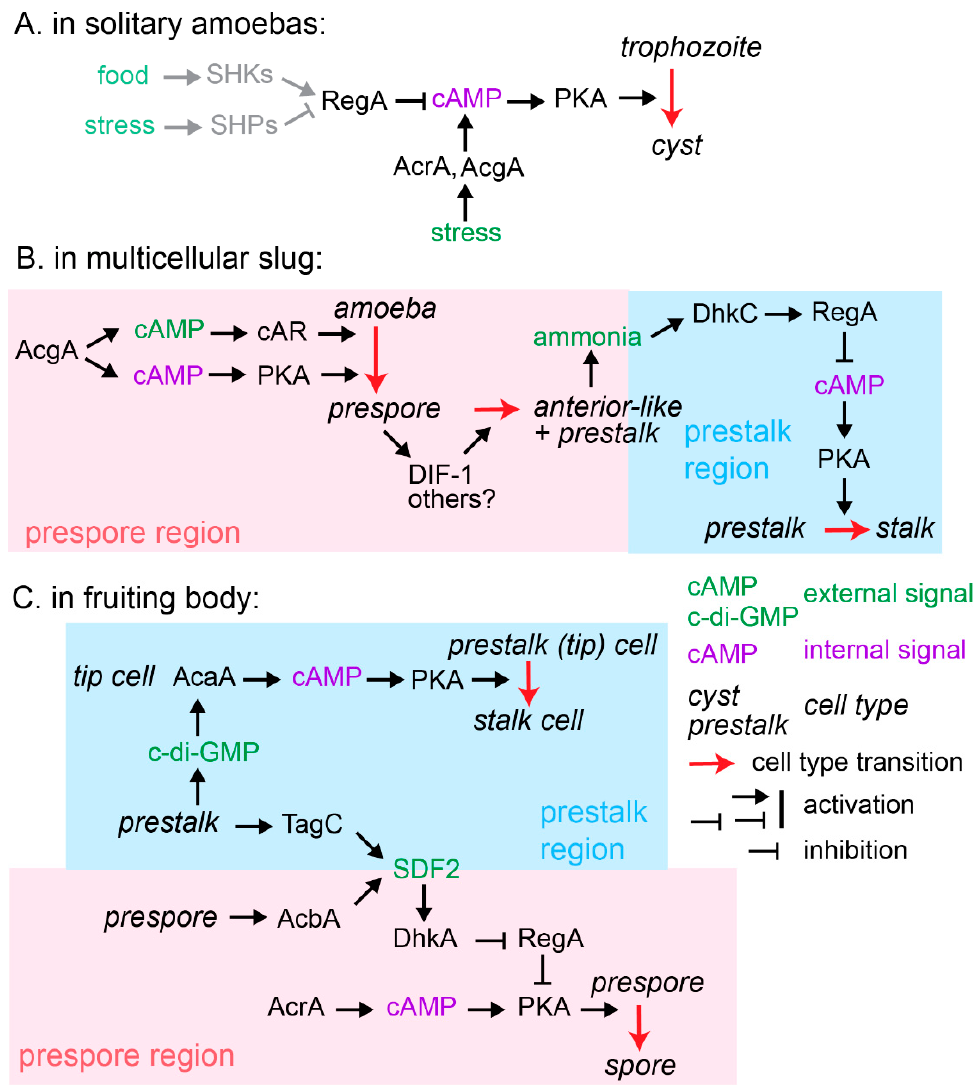
Figure 3. Dictyostelid signalling pathways evolved from an amoebozoan stress response. ( A ). In solitary amoebas, starvation or drought stress increases intracellular cAMP levels to activate (PKA), which induces the transition from growing trophozoite into walled dormant cyst. The cAMP phosphodiesterase, RegA, inhibits this process by hydrolysing cAMP; it bears a conserved response regulator domain that is the target for phosphorylation/dephosphorylation by sensor histidine kinases/phosphatase (SHK/Ps) that, respectively, activate/inactivate the hydrolytic activity. The signal module of SHK/Ps, RegA, PKA, and AcrA is conserved throughout Amoebozoa. ( B , C ) In the multicellular Dictyostelids, this stress pathway came under control of signals exchanged between the cells that regulate the differentiation of walled spores and stalk cells. See main text for details. Other abbreviations: AcrA, AcgA, AcaA: adenylate cyclases R, G, and